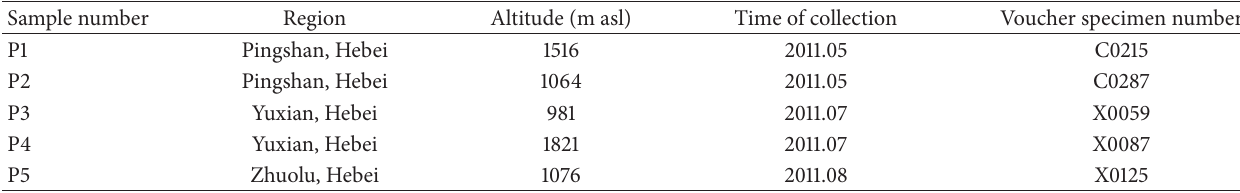
Table 2: Moss plant samples ( Plagiomnium acutum ) collected from different